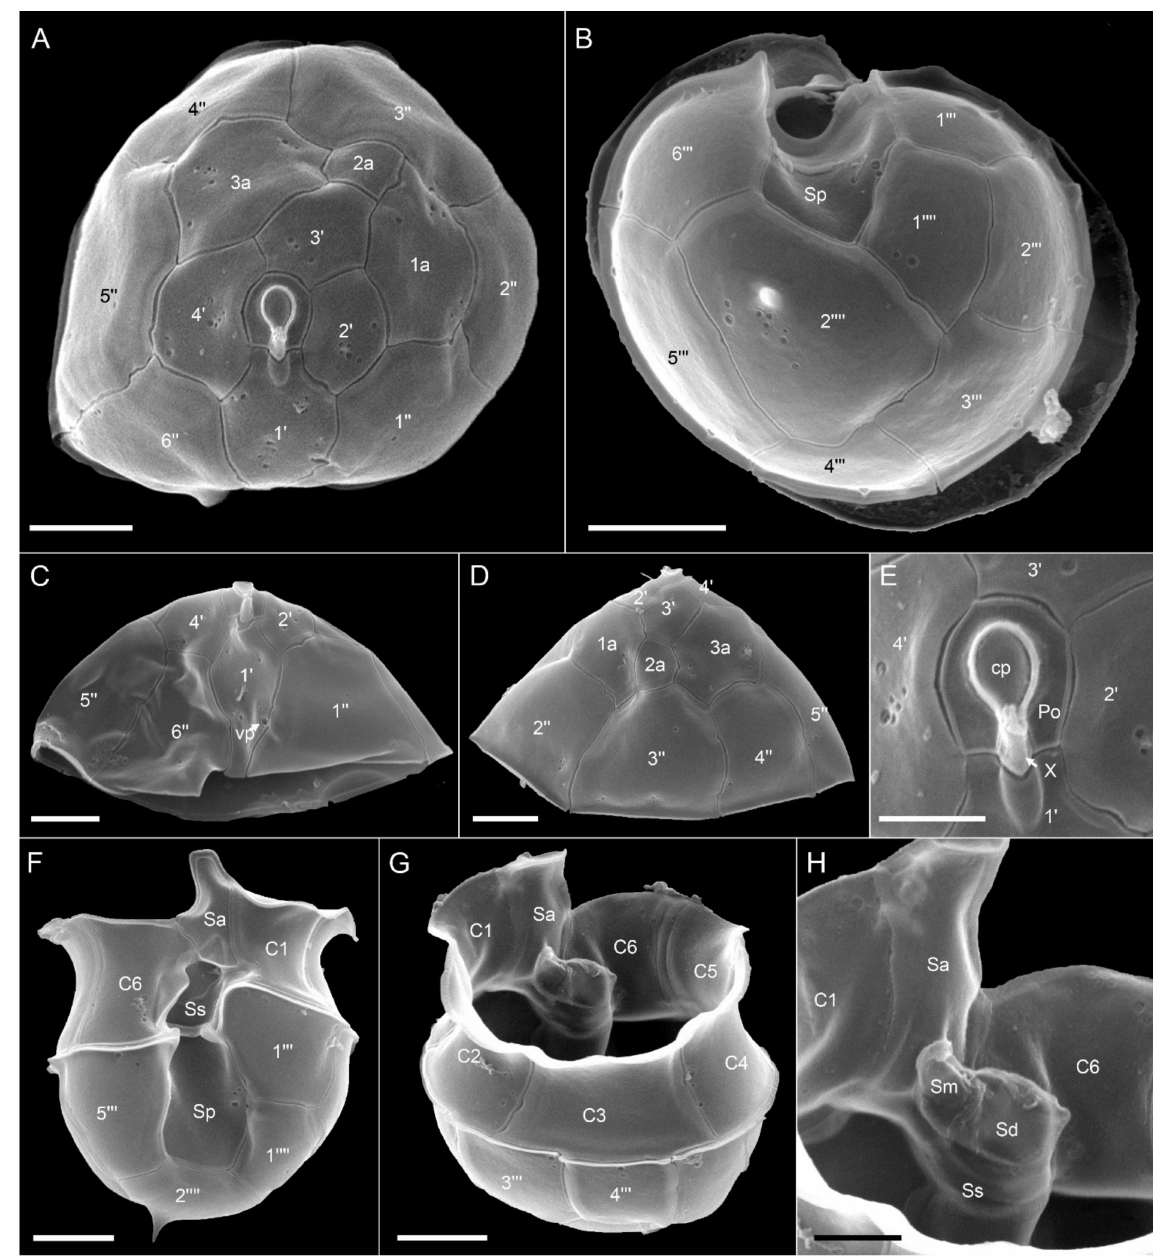
Figure 5. Azadinium spinosum ribotype B strain 5-F6. SEM images of different thecae. ( A ) Apical view of epithecal plates. ( B ) Antapical view of hypothecal plates. ( C ) Epitheca in ventral view. Note the position of the ventral pore (vp). ( D ) Epitheca in dorsal view. ( E ) Detailed view of the apical pore complex (APC). ( F ) Hypotheca in ventral view. ( G ) Hypothecal in apical/dorsal view. ( H ) Detailed internal view of the sulcal plates. Plate labels according to the Kofoidian system. cp = cover plate; Po = pore plate; vp = ventral pore; X = X-plate or canal plate. Abbreviation of sulcal plates: Sa = anterior sulcal plate; Sd = right sulcal plate; Sm = median sulcal plate; Sp = posterior sulcal plate; Ss = left sulcal plate; Scale bars = 2 µ m ( A – D , F , G ) or 1 µ m ( E , H